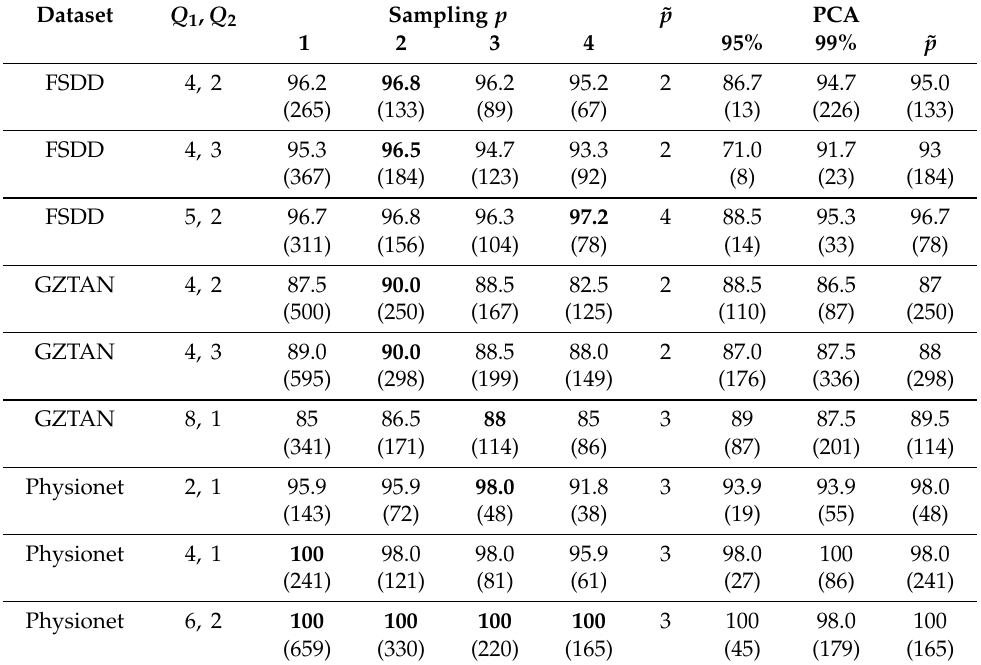
Table 2. 1st col: Dataset; 2nd col: WST Q factors; Cols 3–6: Classification accuracy (%) for